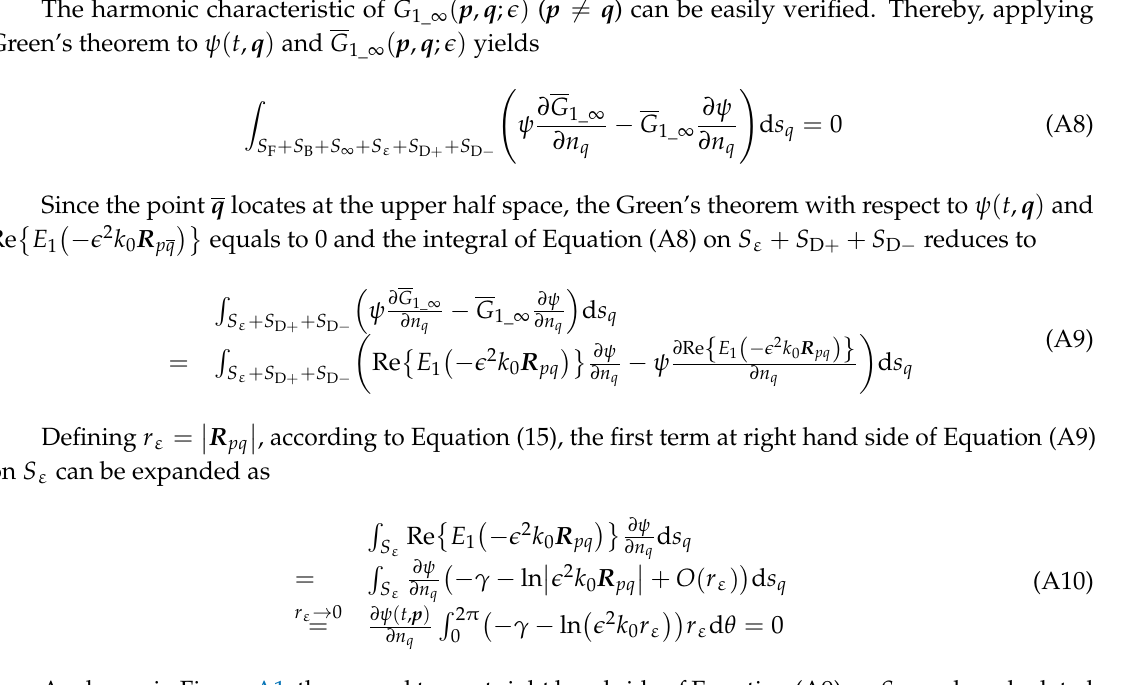
Figure A1. The integral path for the instantaneous term G 1_ ∞ ( p , q ; (cid:101) ) .